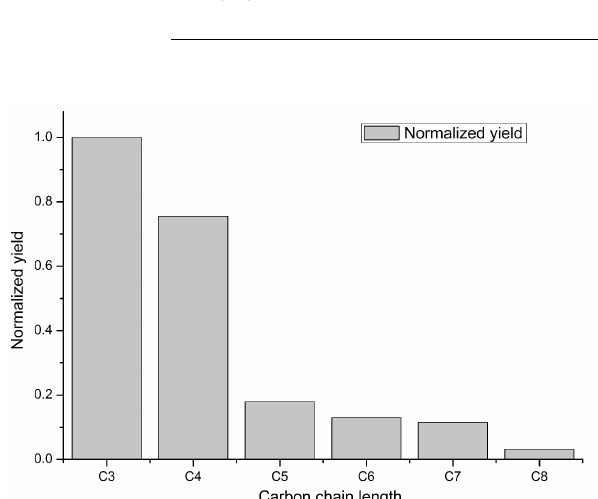
1 Figure 7. Normalized yields of the detected dicarboxylic acids as a function of the carbon 2 Fig. 7. Normalized yields of the detected dicarboxylic acids as a chain length. 3 function of the carbon chain